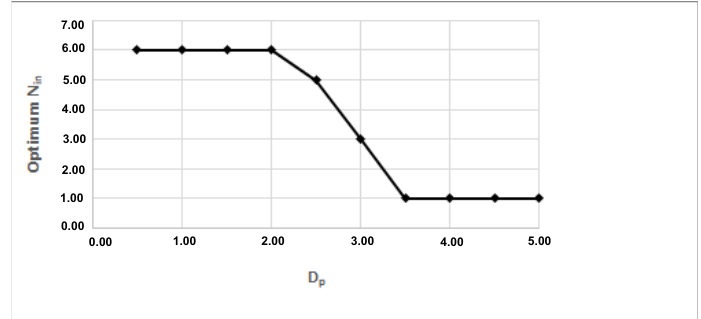
Figure 22. Variations of optimum N in per D p .